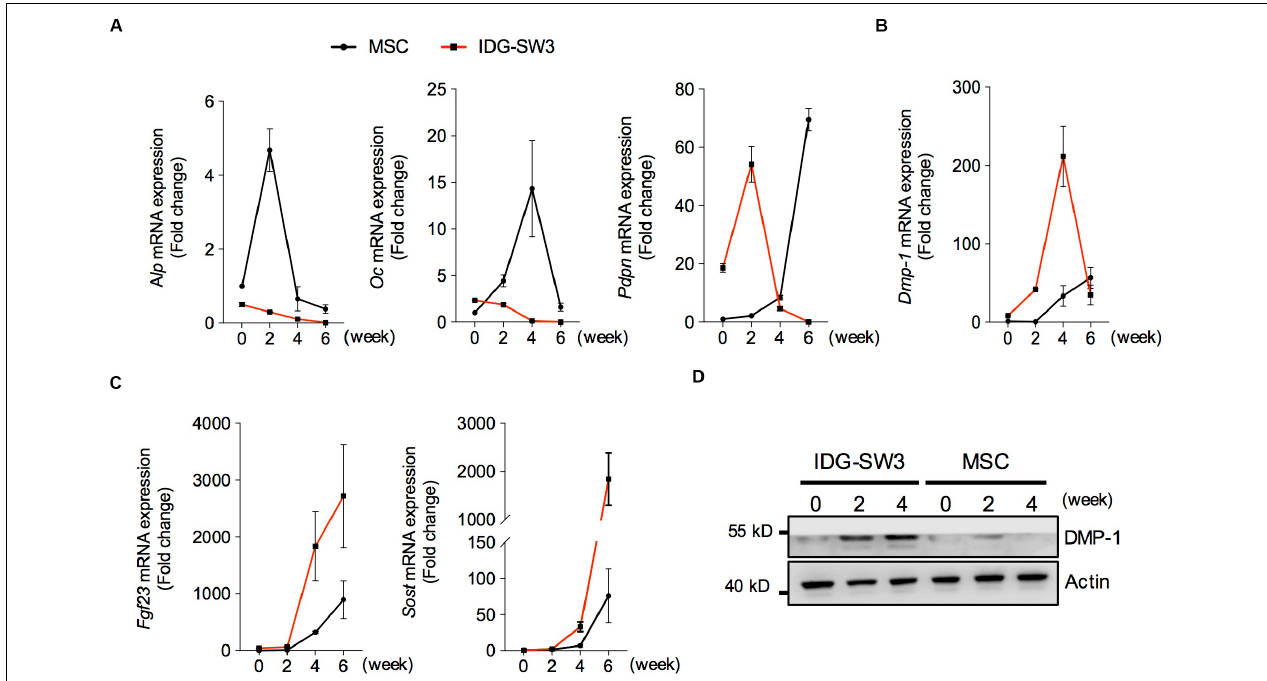
FIGURE 2 | Spatiotemporally proteomic changes of IDG-SW3 cells cultured in collagen gel over time. (A–C) Relative changes of mRNA level of osteoblastic and osteocytic markers expressed in IDG-SW3 cells and BMSCs over differentiating time. (D) The protein level of osteocytic markers expressed in IDG-SW3 cells and BMSCs over differentiating time. Data were represented as means ±